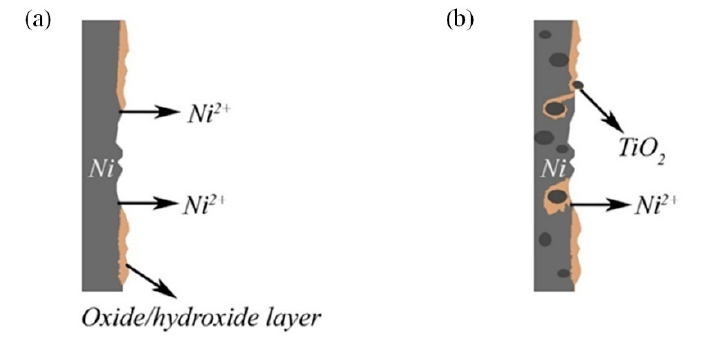
Figure 12. Scheme of dissolution ( a ) Ni and Ni-CeO 2 coatings, ( b ) Ni-TiO 2 .